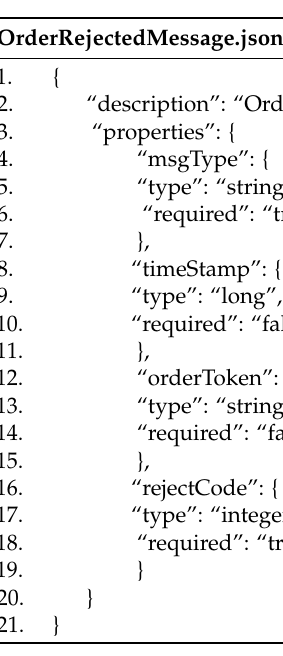
Table A1. Created Json file for OUCH API—Order Rejected